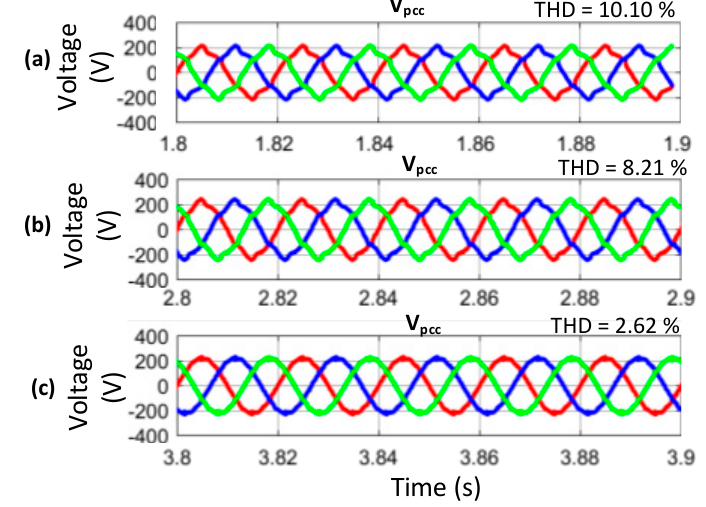
Figure 7. Voltage waveforms of DGs in various steps for the harmonic compensation from left to right. ( a ) First step (without harmonic current compensation); ( b ) second step (with harmonic current compensation); ( c ) third step (enabling the APF).